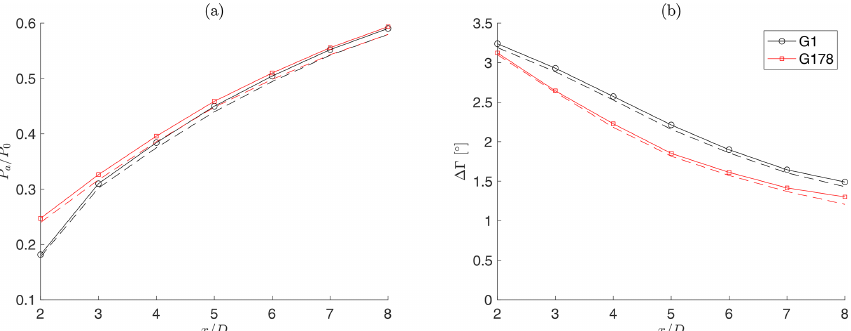
Figure 16. (a) Available power ratio in the wake P a /P 0 as a function of downstream position x/D . (b) Change in wind direction (cid:49)(cid:48) caused by the curled wake as a function of downstream position x/D . Both results are for the 20 ◦ misaligned and medium-TI case. Black ◦ symbols: G1; red (cid:3) symbols: G178. Solid lines: actual wind tunnel size; dashed lines: unrestricted case (no blockage).